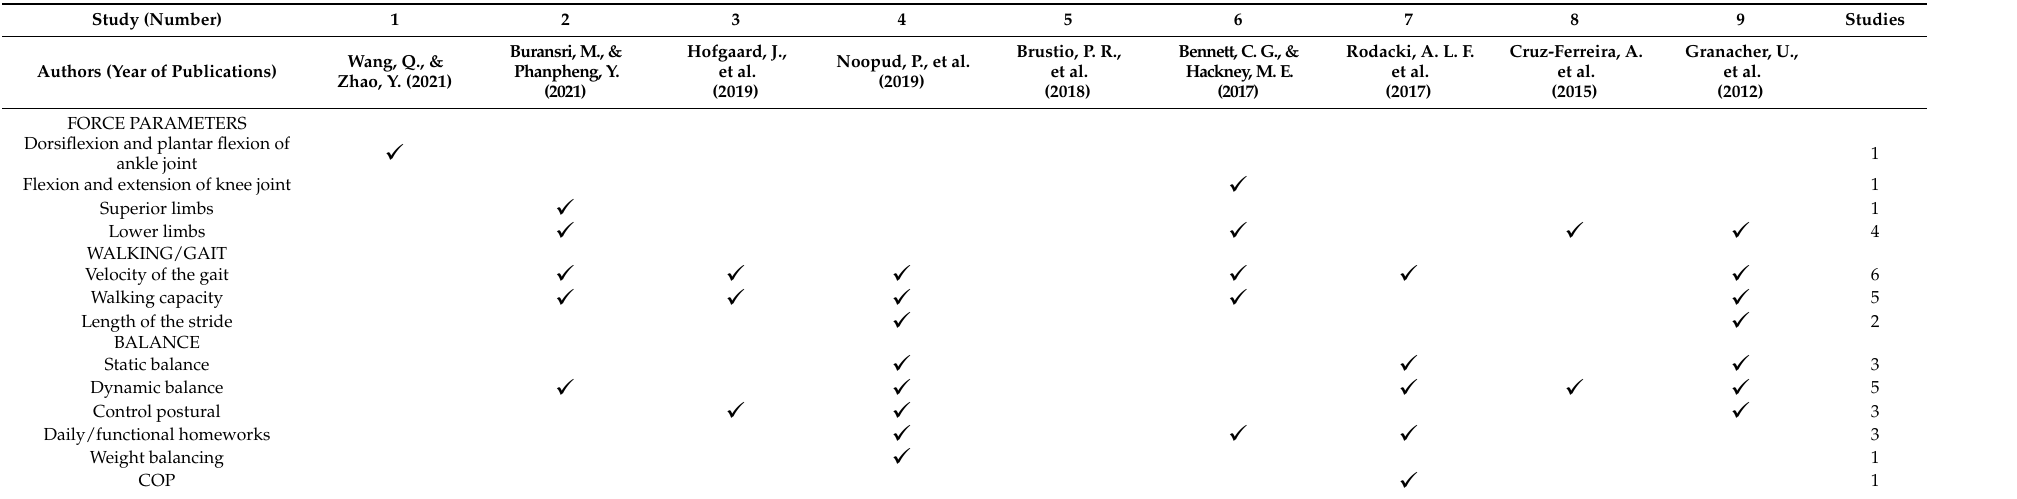
Table 3. Other variables related to mobility and secondary aspects of the psycho-social field were evaluated in the included articles.